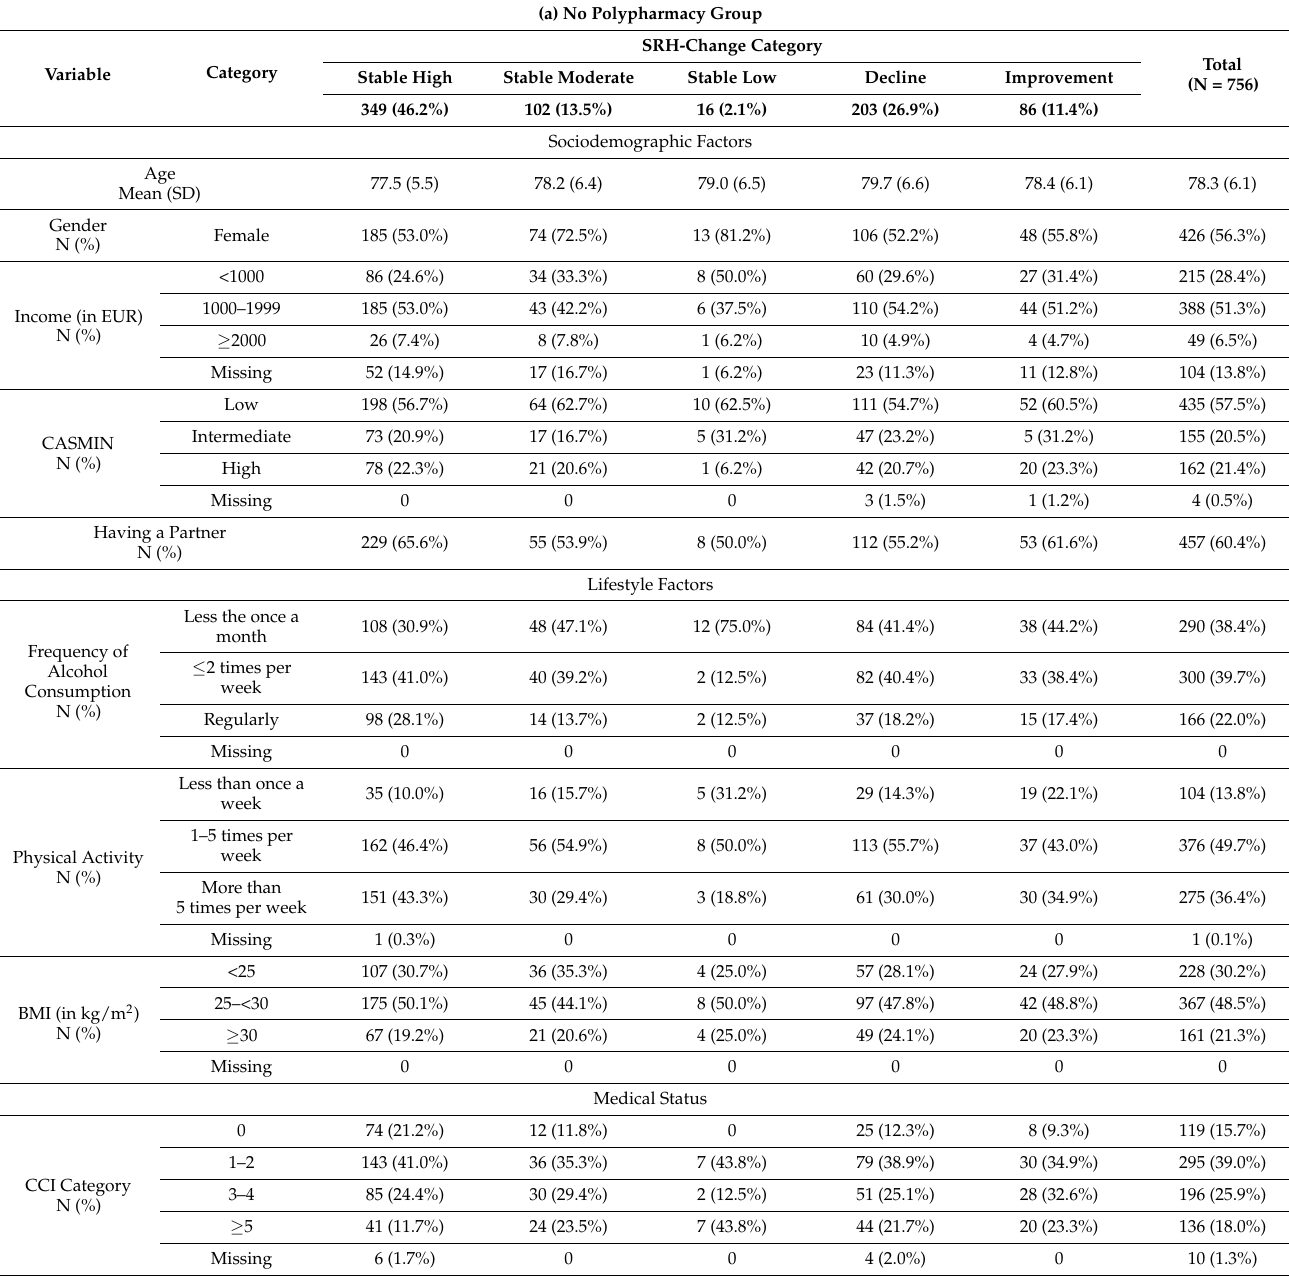
Table 2. ( a ) Baseline characteristics of individuals without polypharmacy by SRH-change category. ( b ) Baseline characteristics of individuals with polypharmacy by SRH-change category. (a) No Polypharmacy